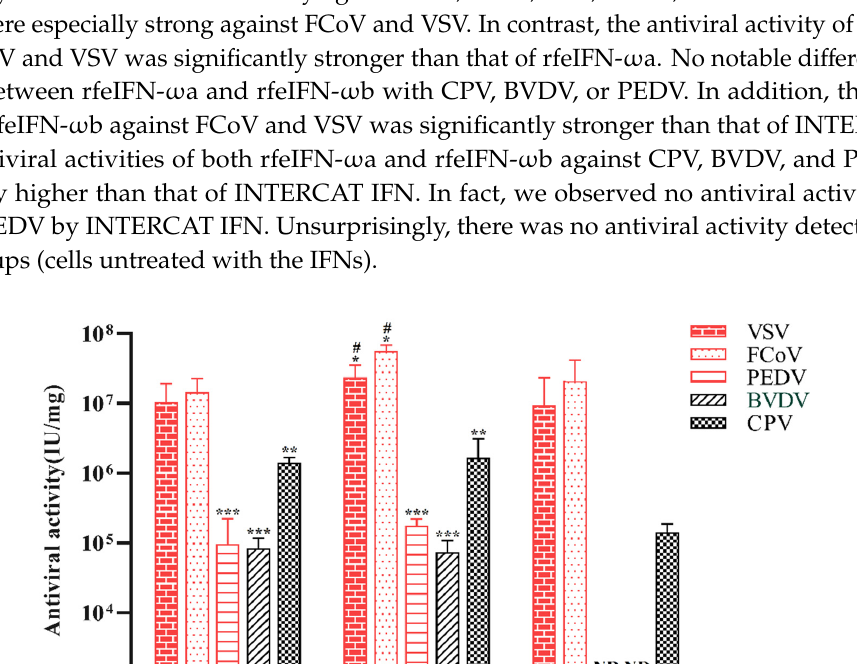
Figure 7. The broad-spectrum antiviral activities of rfeIFN- ω a and rfeIFN- ω b using INTERCAT IFN for comparison. Bars represent the mean ± SEM for each group. Significant differences (* p < 0.05; ** p < 0.01; *** p < 0.001) were observed when comparing the rfeIFN- ω a/rfeIFN- ω b groups to the INTERCAT IFN group. A comparison of the rfeIFN- ω b group and rfeIFN- ω a group also indicated significant di ff erences (# p <